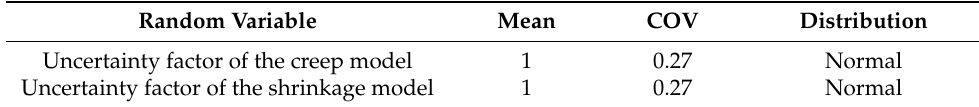
Table 1. Statistical characteristics of the model parameters [26]. Random